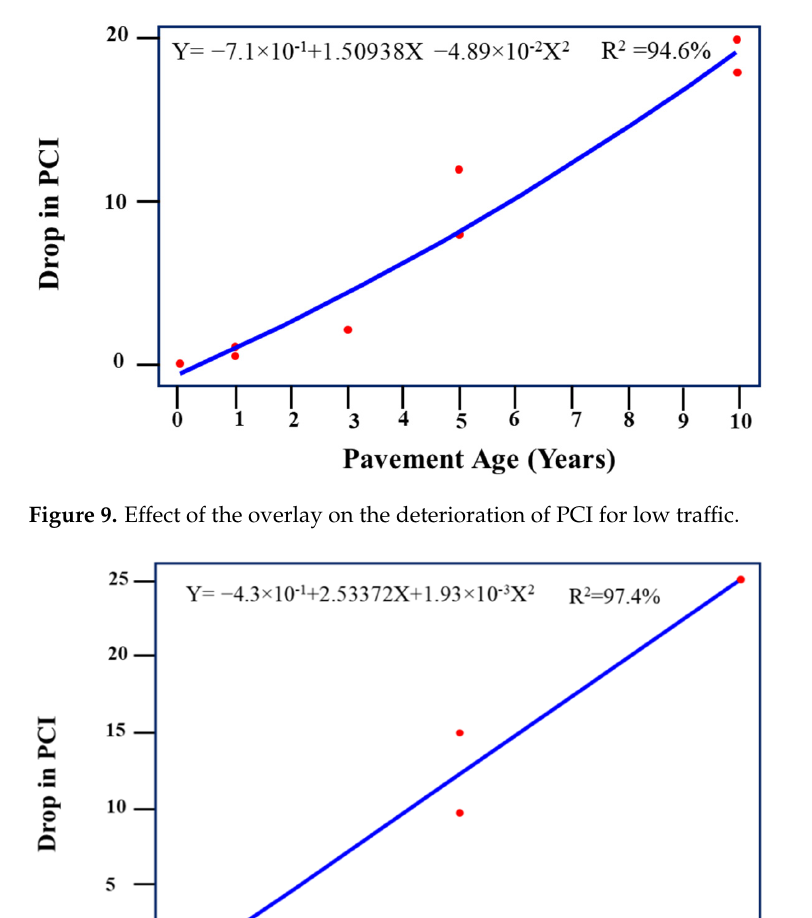
Figure 8. Effect of routine maintenance on the deterioration of PCI for high traffic.